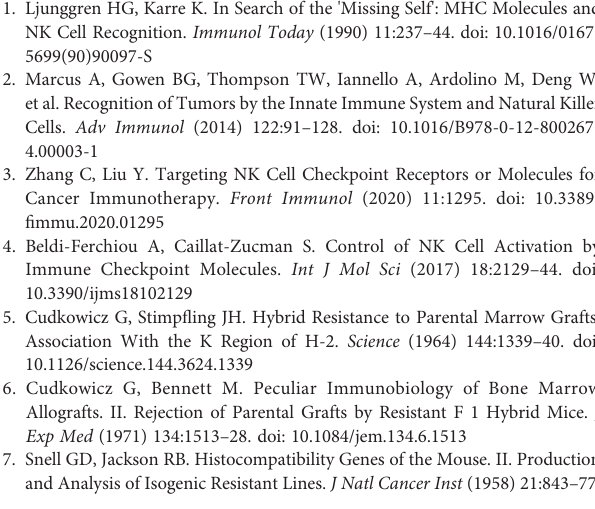
Supplementary Figure 1 | Generation of a PD-L1-de fi cient A20 tumor cell line using a CRISPR-Cas9 approach. (A) The indel mutation located at exon 3 of PD-L1 gene consisted of 5 bp insertion and 21 bp deletion (Genebank accession # OM975989). (B) PCR ampli fi cation of PD-L1 exon 3 from genomic DNA of A20 PD- L1 WT and A20 PD-L1 KO cell line. The expected band for PD-L1 exon 3 in A20 cell linewas342 bpwhereas inPD-L1de fi cientcelllinewas 326bp.Thefollowingsetof primers were used for PCR ampli fi cation: Primer forward exon3-F: 5 ’ CGTTTACTATCACGGCTCC 3 ’ and primer reverse exon 3-R: 5